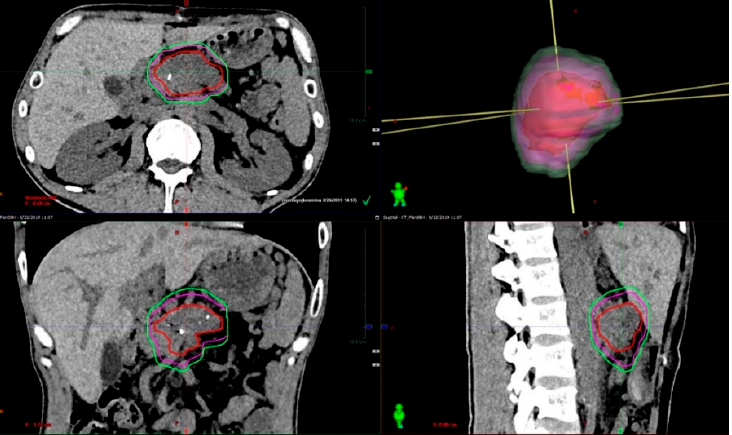
Figure 4. The typical ratio between the GTV (red), ITV (magenta) and c-ITV (light green), presented on MSCT in the coronar, sagittal and transversal planes, and on a 3D reconstruction.